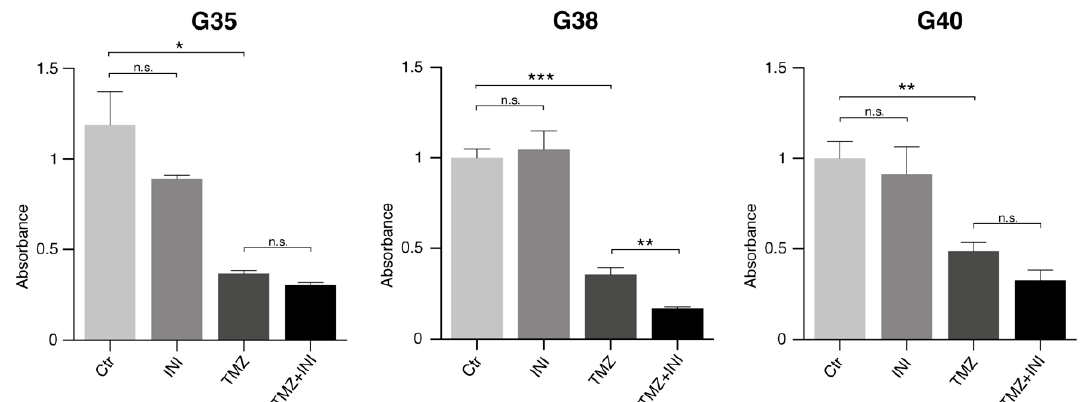
Figure 5. Gap junction-targeted therapy did not markedly affect glioblastoma cell proliferation. Treatment was performed with 50 µM TMZ, 100 µM INI, or combination of both. The amount of incorporated BrdU as surrogate readout for cell proliferation was determined by measuring the absorbance at 370 and 492 nm 144 h after treatment. Mean ± SD is depicted. *, ** and *** denote p < 0.05, p < 0.01 and p < 0.001. Ctr, control; G, glioblastoma; and TMZ, temozolomide.